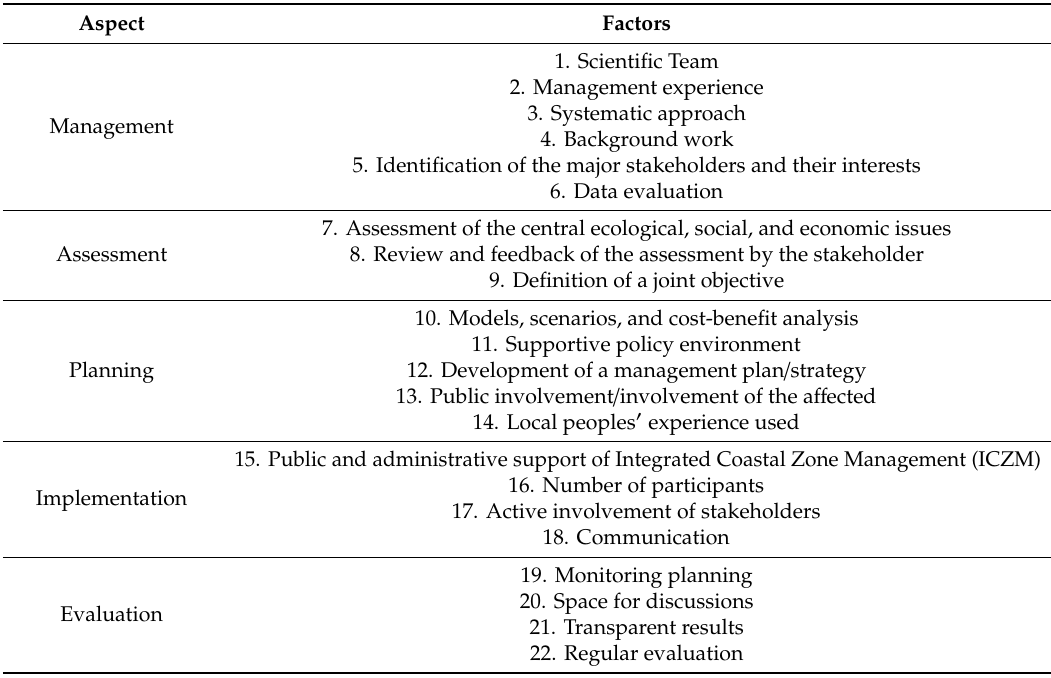
Table 2. Strengths-Weaknesses-Opportunities-Threats (SWOT) factors regarding the Systems